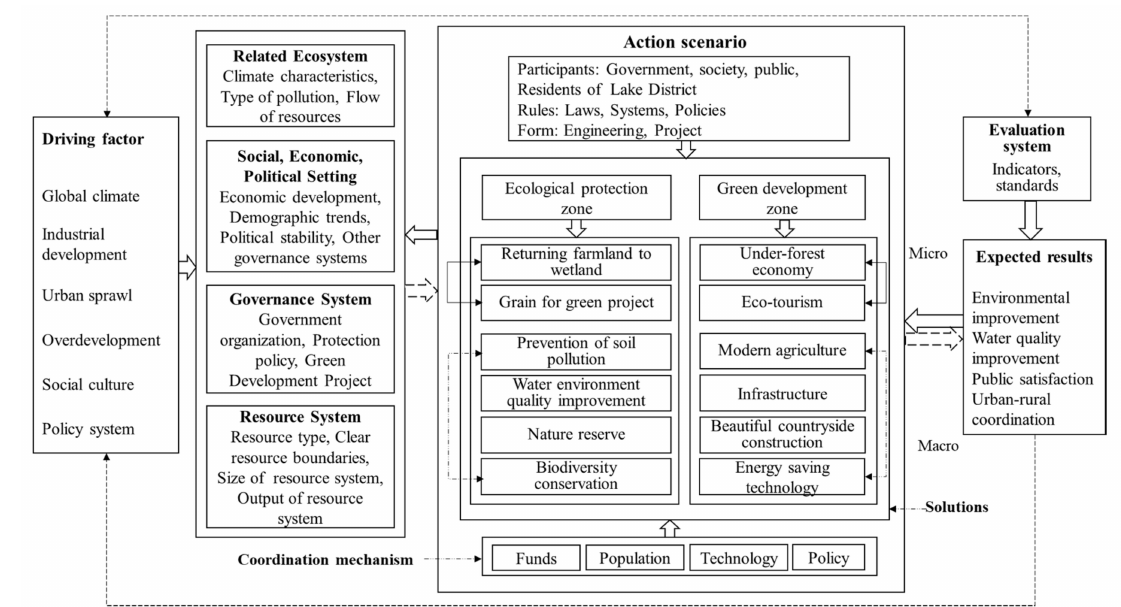
Figure 5. Action scenario setting based on social-ecological system (SES)